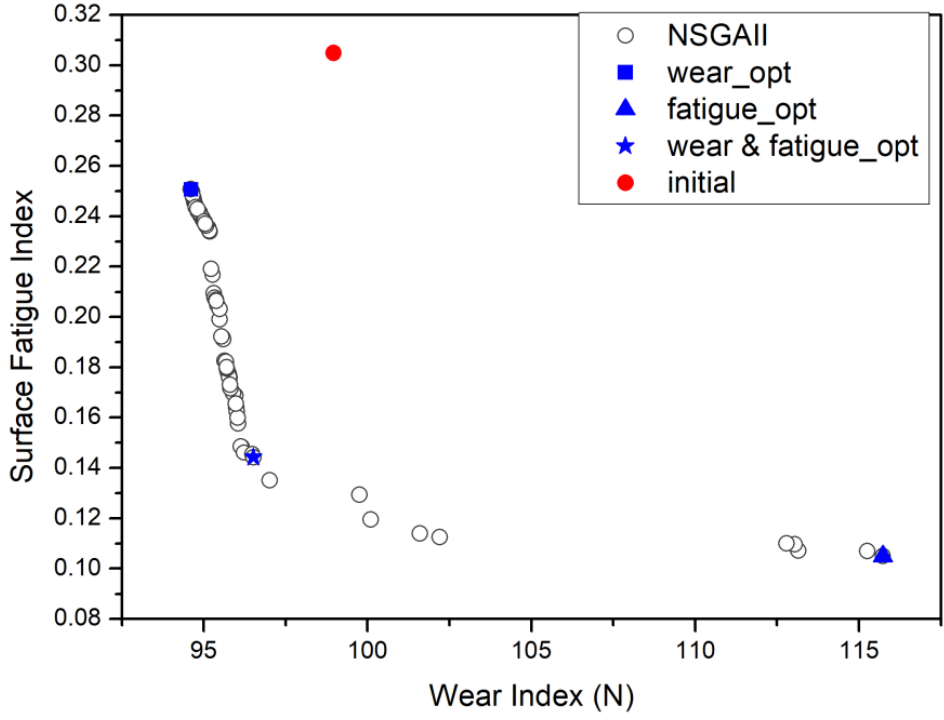
Figure 6. Pareto optimum results of multi-objective functions.